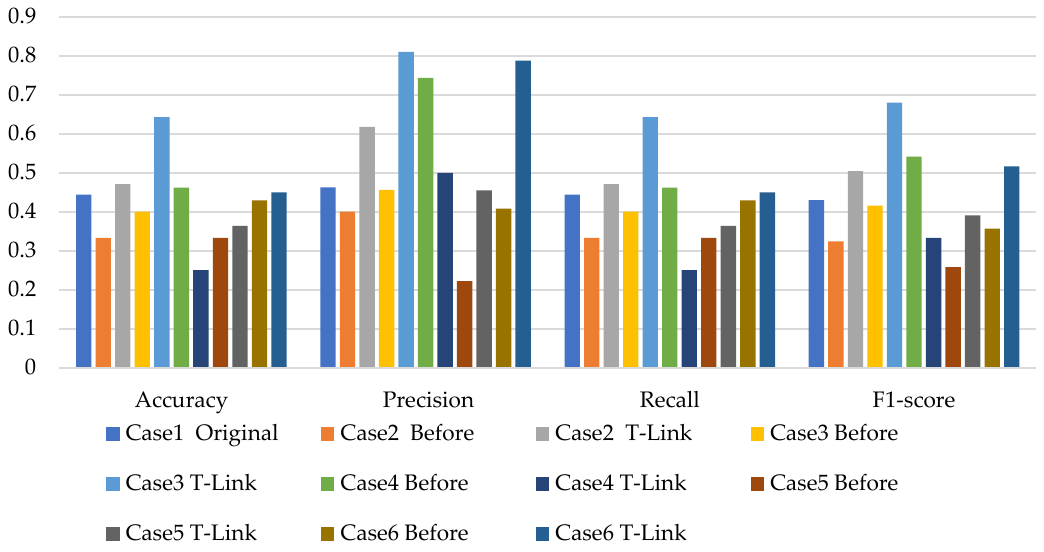
Figure 15. Experimental performance of NBC classification with T-link.